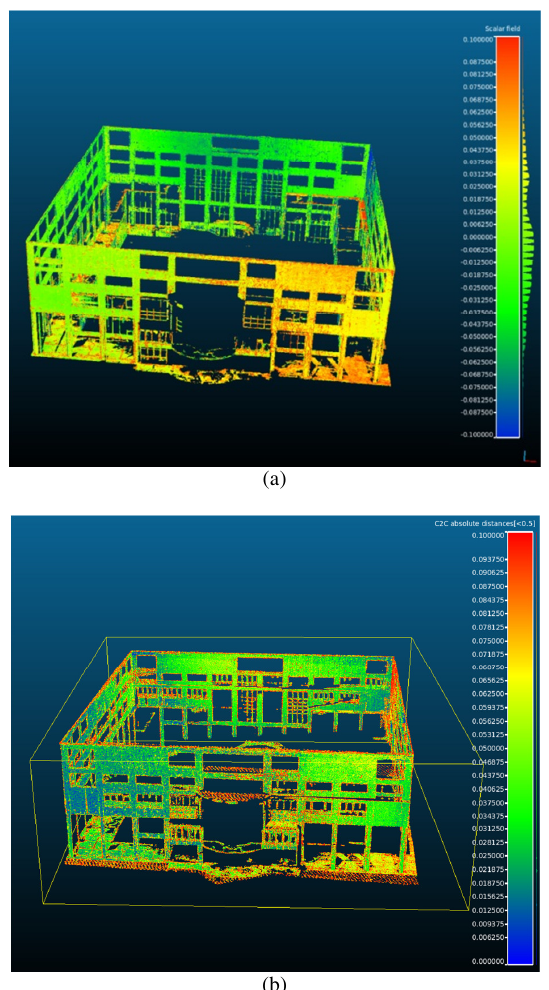
Figure 11. Evaluation of a dense point cloud: (a) signed distance from our approach, (b) absoute point-to-point distance. Maximum absolute error 10cm in both cases.